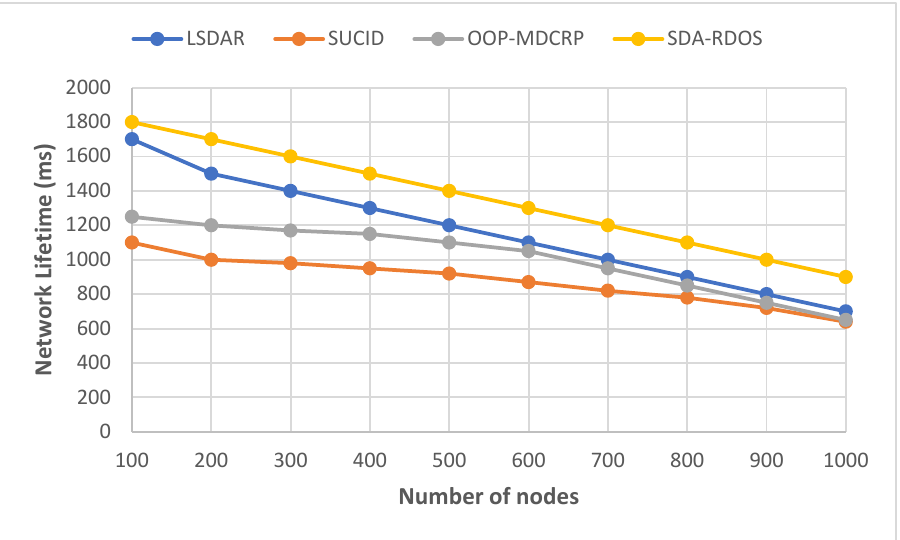
Figure 17. Network Lifetime Analysis of LSDAR, SUCID, OOP ‐ MDCRP, and SDA ‐ RDOS protocols.